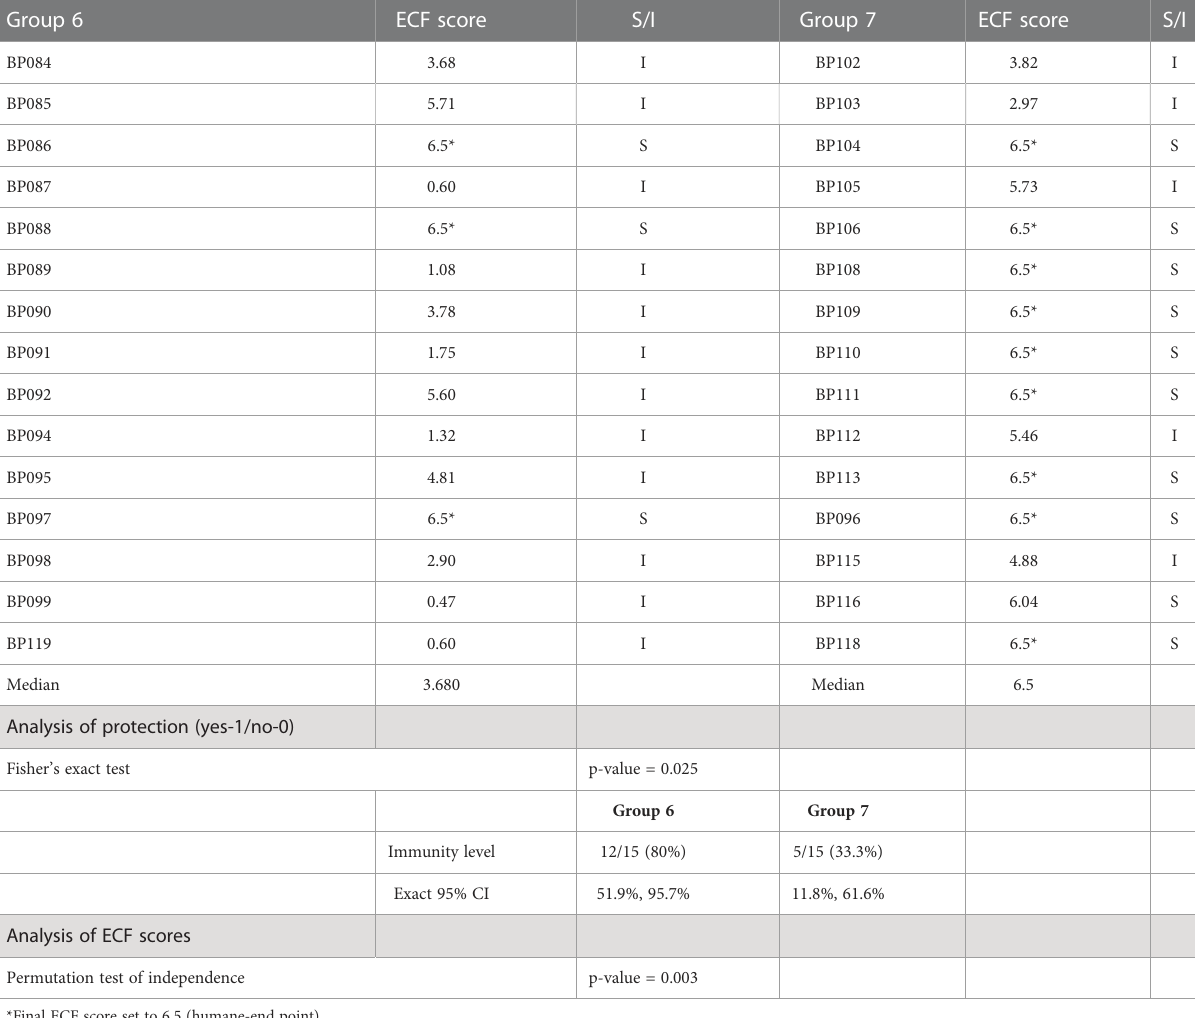
TABLE 5 Summary of protection results and statistical analysis of protection and ECF score differences between groups 6 and